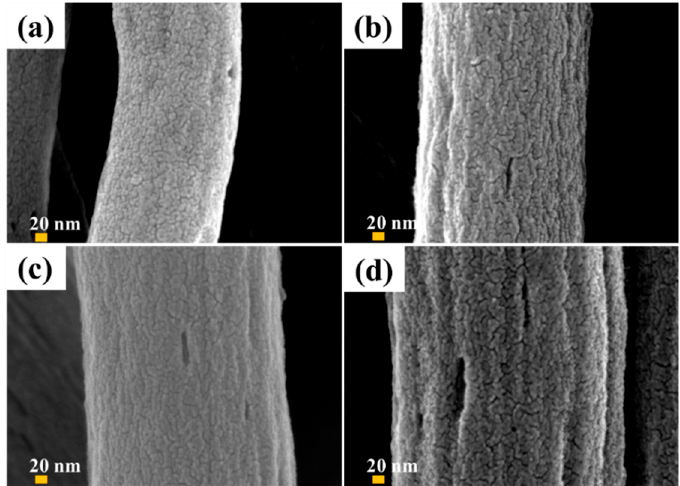
Figure 2. SEM surface images of carbon nanofibers obtained with different ceramic pressure load at 59:41 weight ratio of PAN/PMMA: ( a ) 0 N, ( b ) 0.62 N, ( c ) 1.12 N, ( d ) 1.28 N.